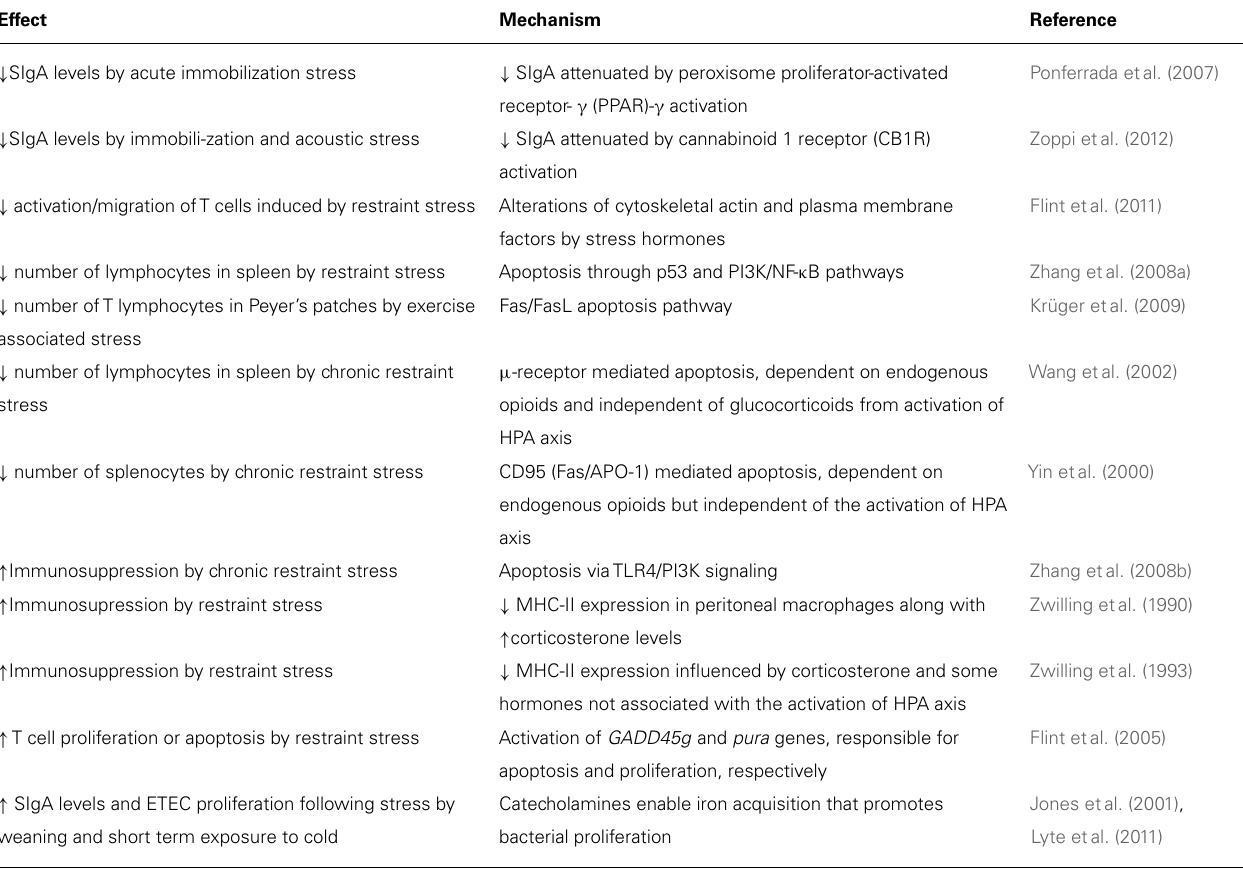
Table 2 | Mechanisms of immune modulation by